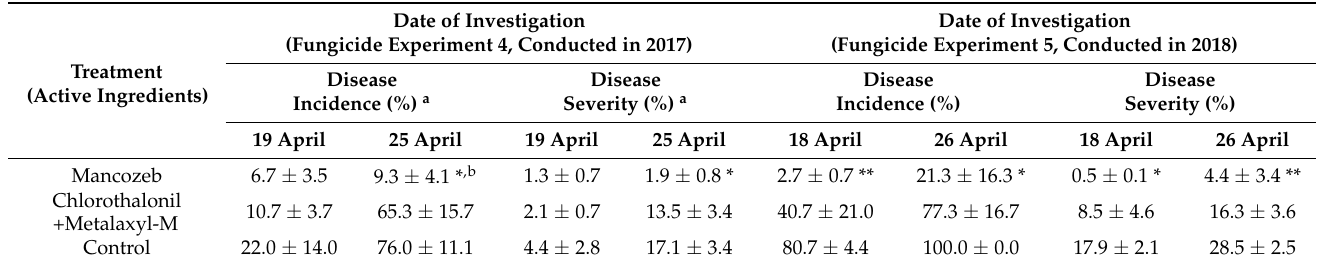
Table 5. Effects of fungicide treatments on onion downy mildew in 2017 and 2018.